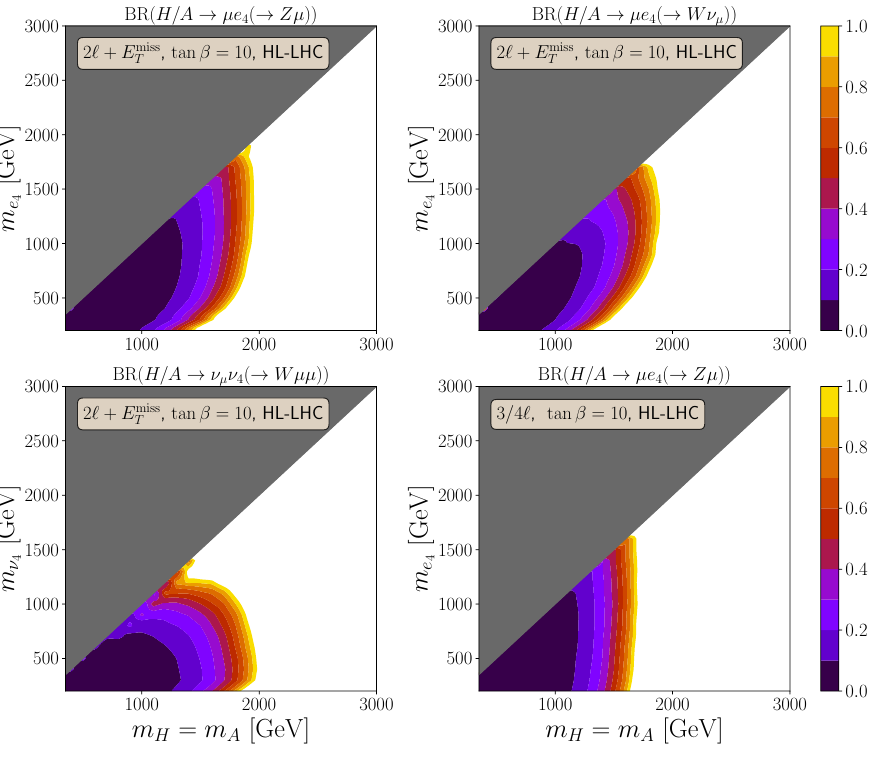
Figure 10 . Future upper bounds on the branching fractions when tan β = 10